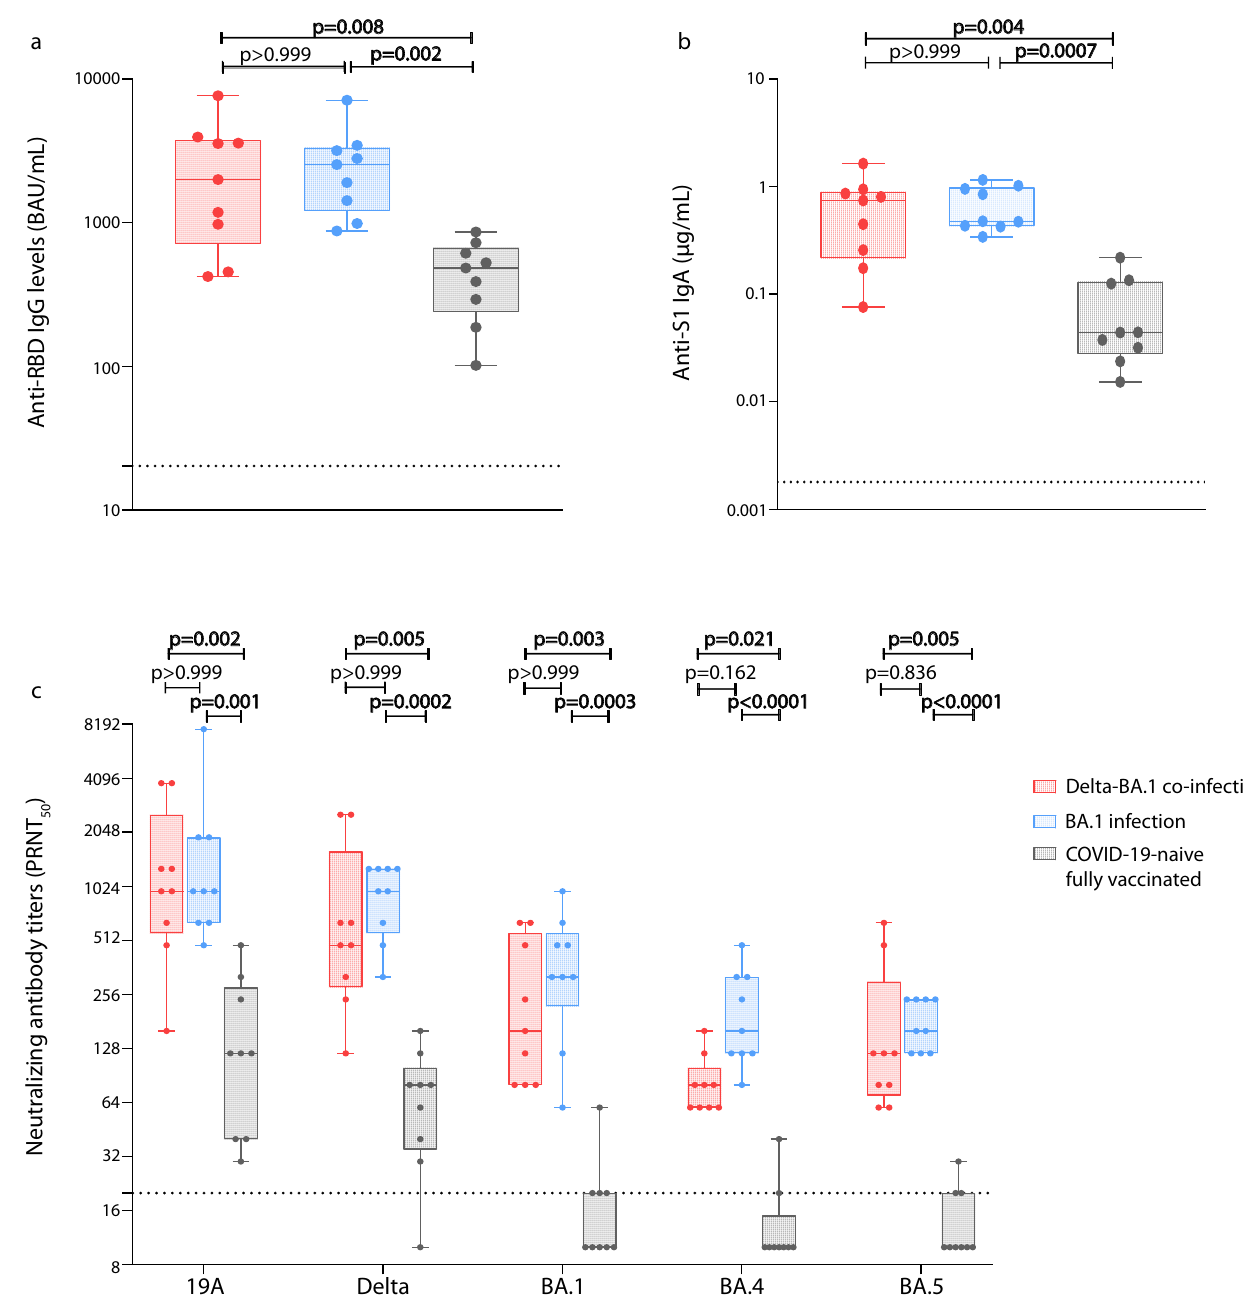
Fig. 1 Humoral immune response 6 months after last immunization in individuals vaccinated and then co-infected with Delta and BA.1, or vaccinated and then infected with BA.1, or in COVID-19-naïve fully-vaccinated individuals. Blood samples were obtained 6 months after infection for the fi rst two groups or 6 months after the third injection for the third group. Anti-RBD IgG levels were measured using the commercially available bioMérieux Vidas SARS-CoV-2 IgG diagnosis kit according to manufacturer ’ s recommendations and expressed in binding antibody unit (BAU)/mL. The dotted line represents the threshold of positivity ( ≥ 20.33 BAU/mL; a ). Anti-S1 IgA levels were measured using an ELISA test and expressed in µg/mL. The dotted line represents the positivity threshold ( ≥ 0.0018 µg/mL; b ). Neutralizing antibody titers against live SARS-CoV-2 isolates using a 50% plaque reduction neutralization test (PRNT 50 ). The isolates used for these experiments were 19A, Delta, Omicron BA.1, BA.4, and BA.5; their GISAID accession numbers are EPI_ISL_1707038, EPI_ISL_1904989, EPI_ISL_7608613, EPI_ISL_12396843, and EPI_ISL_12852091, respectively. The dotted line represents the positivity threshold (titer ≥ 20; c ). Data are represented as box and whiskers plot; in each plot, the dots indicate individual samples, the upper and lower limits of the box plot represent the interquartile range [IQR] and the middle line represents the median. Whiskers represent the maximum and minimum value in each plot. All box and whiskers plots represent n = 9 biologically independent samples. A Kruskal – Wallis test followed by Dunn ’ s multiple comparison tests were performed to assess differences between the three